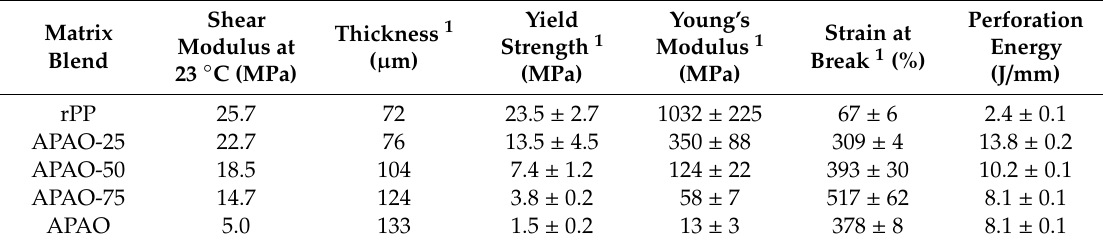
Table 3. Fiber content, density, peel strength and tensile properties of the composites.